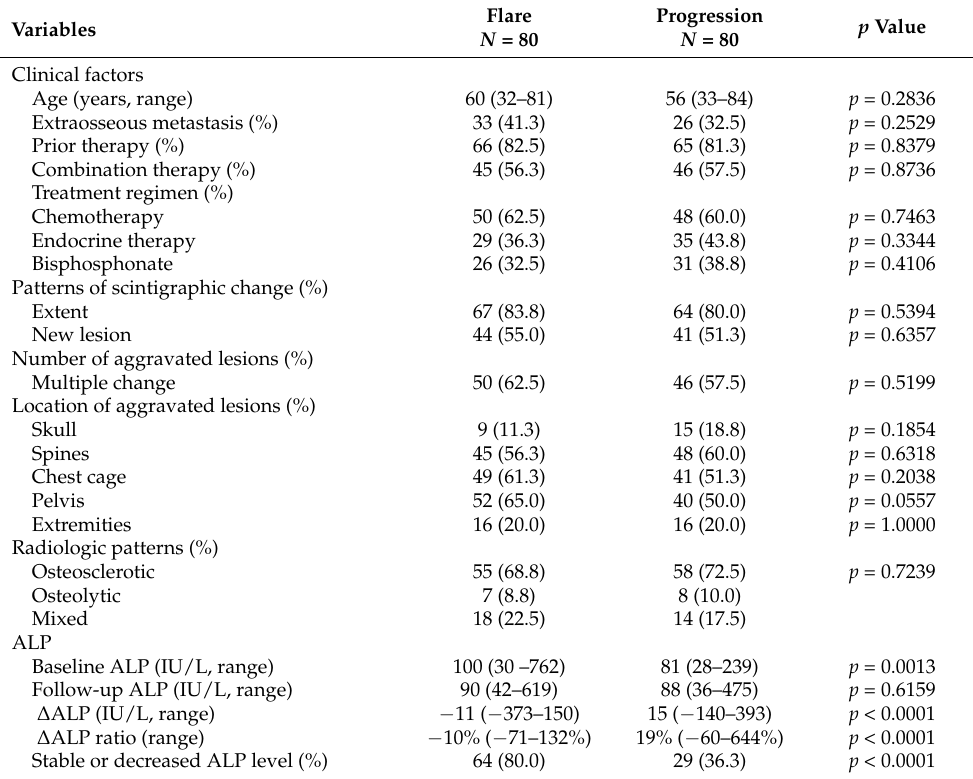
Table 2. Univariate analysis between flare and progression